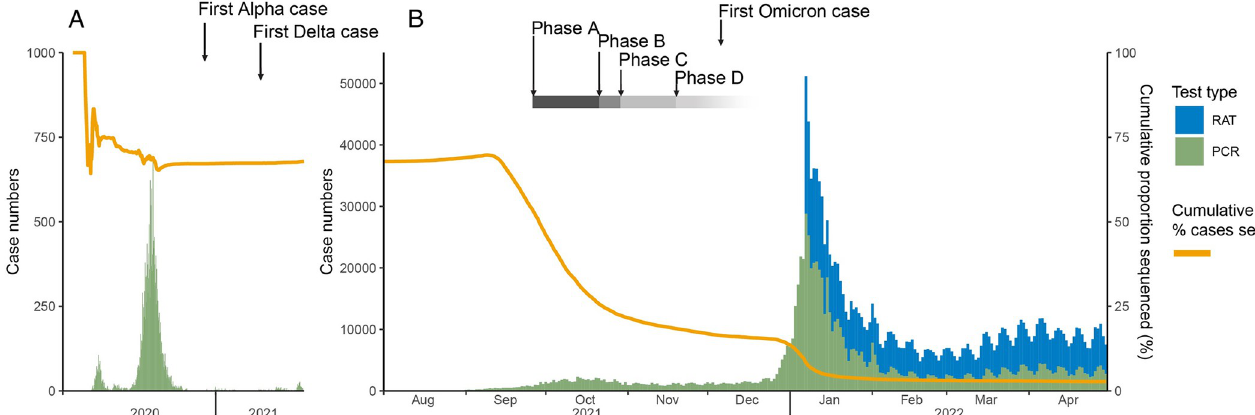
Fig 1. Epidemiological curve of SARS-CoV-2 in Australia, demonstrating the rapid rise in cases in 2022 upon emergence of the Omicron variant, and the diminishing cumulative proportion of cases sequenced. Panel A has a reduced scale to visualise the limited case numbers during January 2020 to July 2021 inclusive. Panel B includes data from August 2021 to April 2022 inclusive. The case numbers (Y-axis, left) obtained from PCR tests and rapid antigen tests (RAT) are respectively shown in green and blue. The cumulative percentage of cases sequenced (Y-axis, right) is visualised as an orange line. The emergence of variants of concern (Alpha, Delta and Omicron), as well as the 4 phases of the Victorian Government’s “Roadmap” [2] for easing COVID-19 restrictions, are shown at the top of the curve. The Victorian Roadmap is an example of jurisdiction-managed responses to the COVID-19 pandemic. The roadmap included four phases (A-D) that gradually eased restrictions on travel and social distancing measures, partly based on the percentage of the population fully vaccinated. Phase A focused on returning students to the classroom, whereas Phase B and C guided the return to work and travel upon reaching vaccination targets of 70% and 80% of the population (16+) fully vaccinated, respectively. The final stage, Phase D, was reached when 80% of the population (12+) was fully vaccinated, allowing the restrictions to ease and align with Australia’s National COVID-19 response.